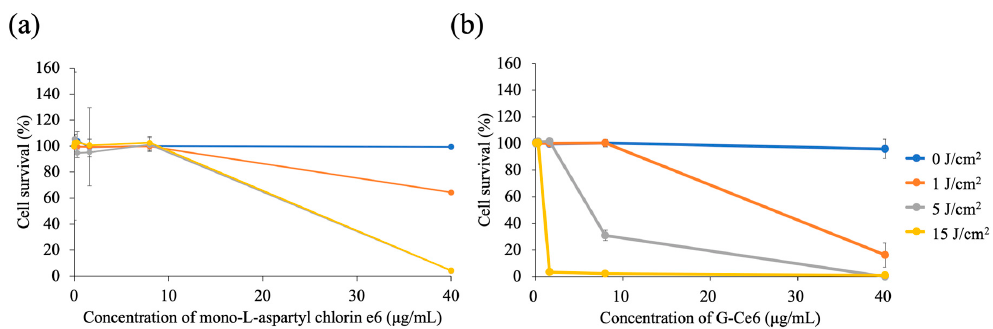
Figure 4. Photodynamic cytotoxicity in SNP cells. The cells were incubated with various concentrations of ( a ) mono-L-aspartyl chlorin e6 (NPe6) and ( b ) glucose-conjugated chlorin e6 (G-Ce6) for 24 h at 37 ◦ C. After washing with fresh media, the cells were irradiated with 650-nm laser light (10 mW / cm 2 ; 0, 1, 5, and 15 J / cm 2 ). The viability of SNP cells at 24 h after photodynamic therapy, along with IC 50 values, were determined. ( a ) The IC 50 values of NPe6 at light doses of 1, 5, and 15 J / cm 2 were 75.2, 30.4, and 30.6 µ g / mL, respectively. ( b ) The IC 50 values of G-Ce6 at light doses of 1, 5, and 15 J / cm 2 were 33.4, 10.4, and 1.7 µ g / mL, respectively. IC 50 , half-maximal inhibitory concentration. Results are presented as the mean ± standard deviation.